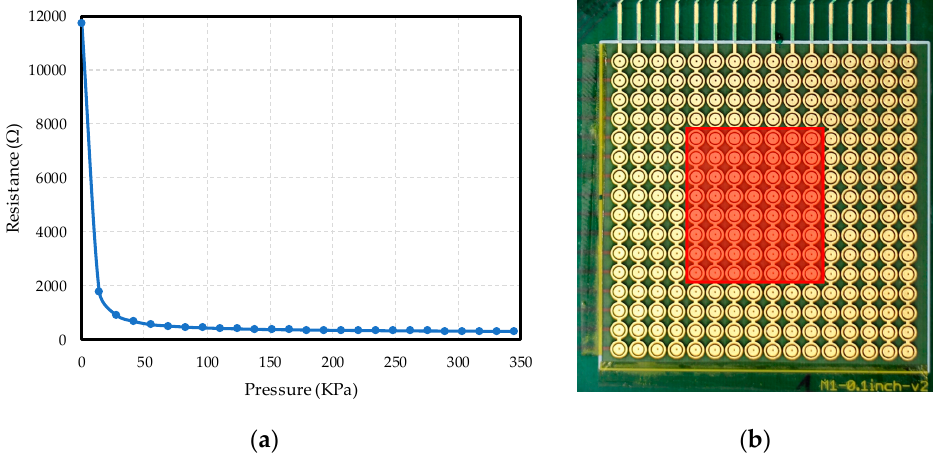
Figure 8. ( a ) Average calibration curve for sensors in the array; ( b ) Active area of the tactile sensor used.